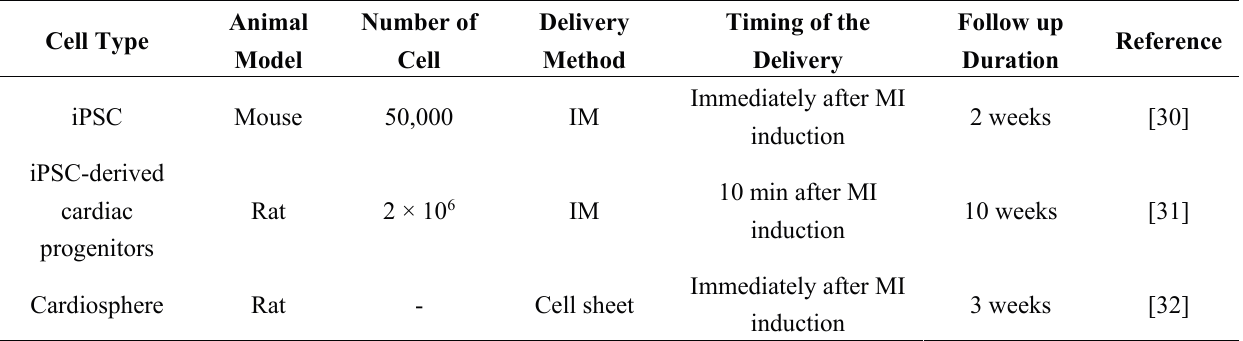
Table 1. Examples of using iPSCs in cell replacement